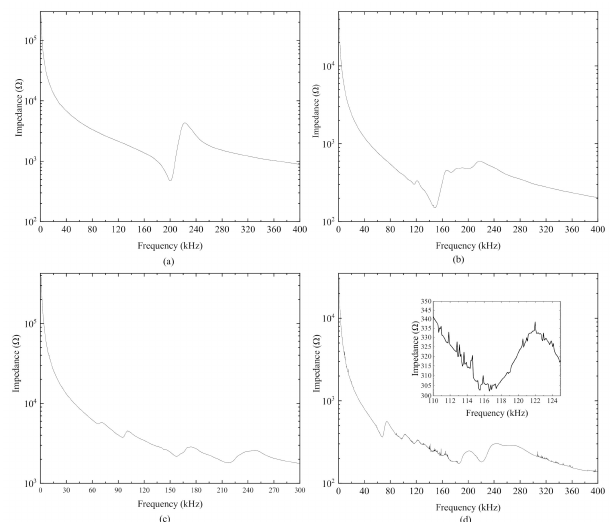
Figure 13. The measured impedances of PiSSAs with di ff erent number of PZT wafers in series or parallel connection: ( a ) four series PZT wafers; ( b ) four parallel PZT wafers; ( c ) six series PZT wafers; and ( d ) six parallel PZT